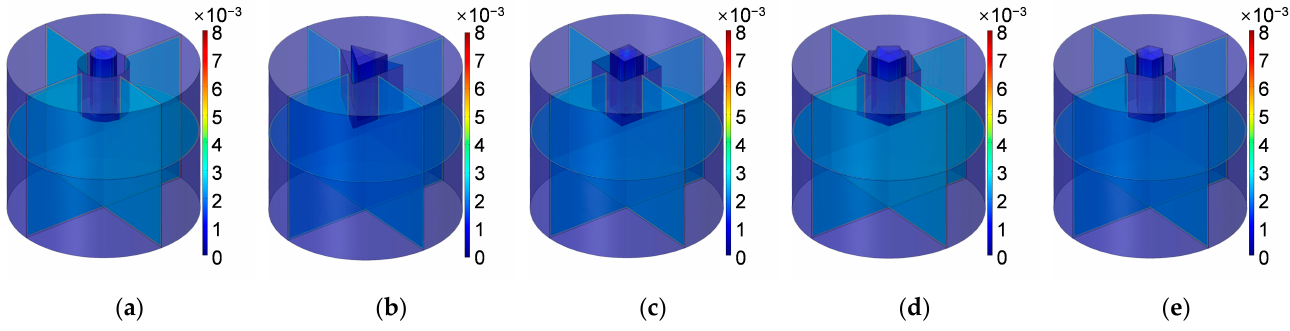
Figure 23. Distribution of temperature for the HR with aperture for various cross-sectional shapes.